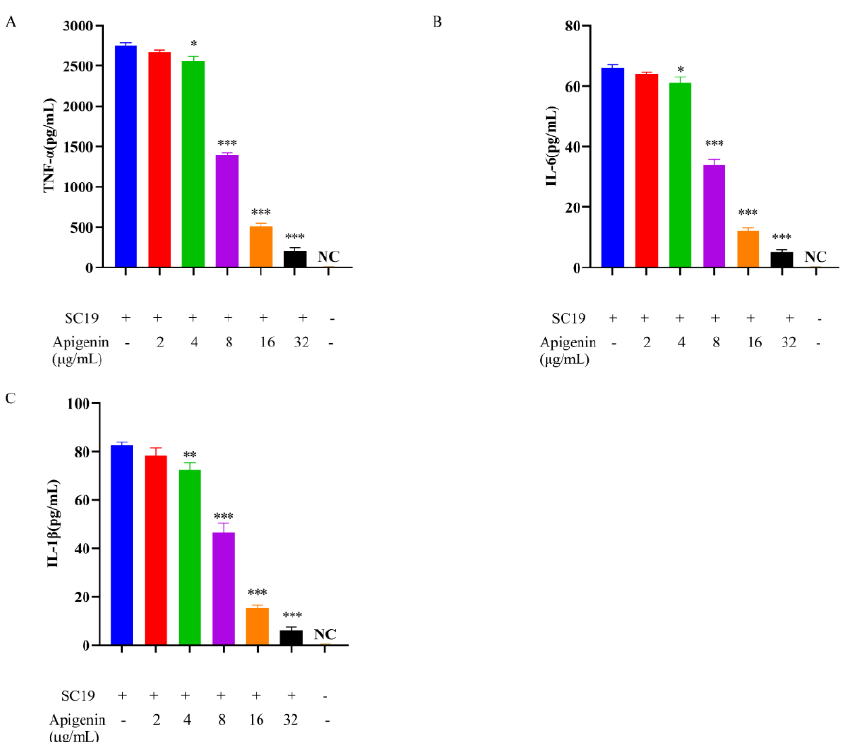
Figure 3. Apigenin reduced SS2-mediated cytokine production at the cellular level. ( A ) TNF- α, ( B ) IL-6, ( C ) IL- 1β. Cells were incubated with SS2 (MOI = 10:1) and different concentrations of apigenin for 6 h. ELISAs was used to determine the concentrations of TNF- α, IL - 1 β , and IL- 6. “NC” NC “ represents no treatment with SC19. * p < 0.05; ** p < 0.01; *** p < 0.001 versus SS2 alone.